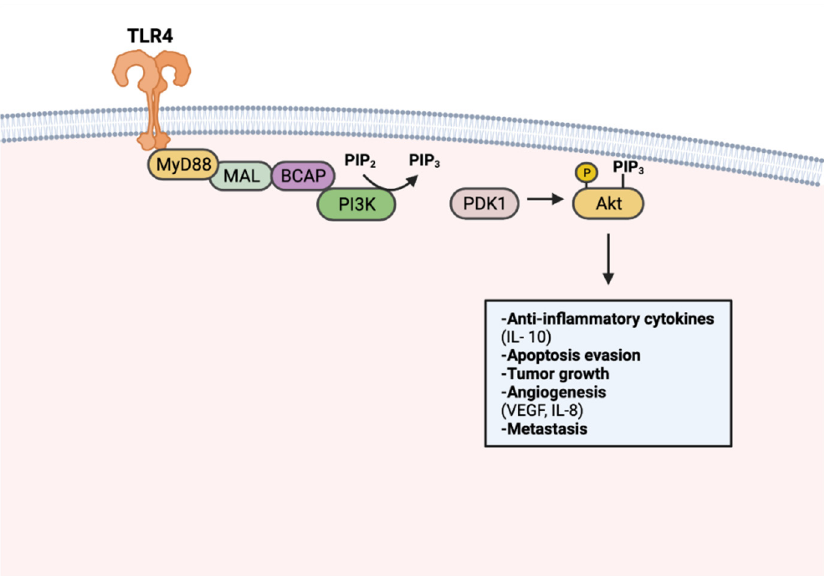
Figure 3. TLR-mediated PI3k-Akt signaling in tumorigenesis. PI3k is activated upon TLR stimulation through MyD88, MAL, and BCAP. Activated PI3k converts phosphatidylinositol 4,5-bisphosphate (PIP 2 ) to phosphatidylinositol (3,4,5)-trisphosphate (PIP 3 ). Akt activation occurs through PIP 3 - facilitated recruitment to the plasma membrane and phosphorylation by PDK1. Activated Akt promotes tumor progression through anti-inflammatory cytokine production, apoptosis resistance, tumor growth, angiogenesis, and metastasis. Created with Biorender.com.